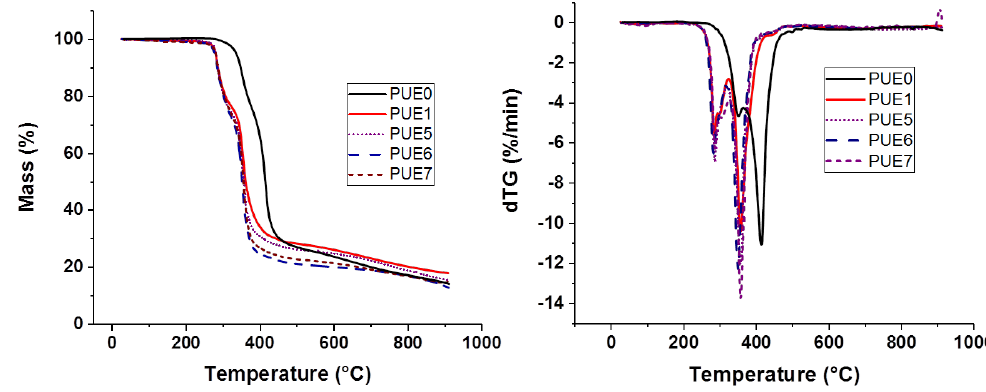
Figure 12. TG and DTG curves for PUE/APP/lignin composites.